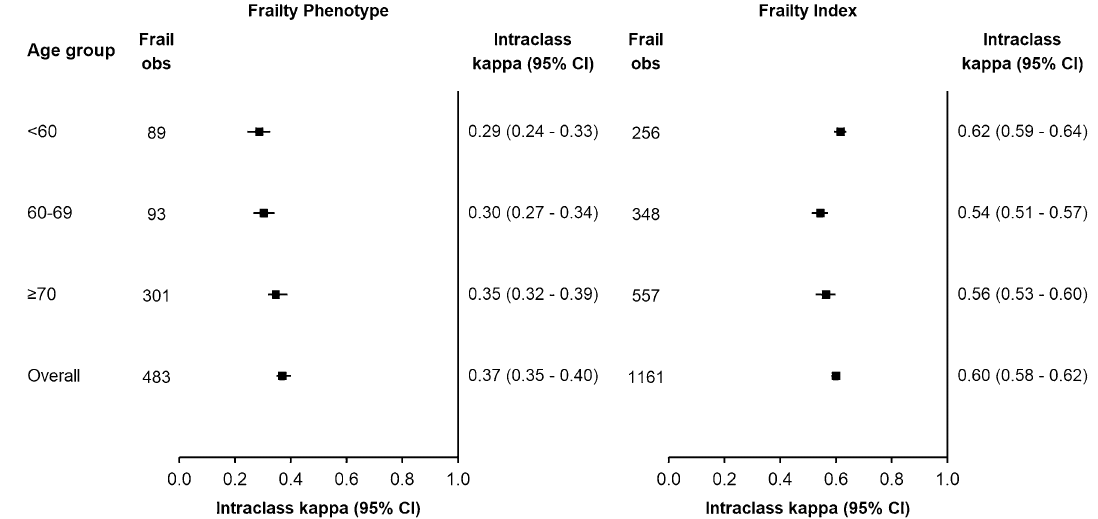
Figure 1. Agreement in classification of frailty over 2 years using frailty phenotype and frailty index, overall and by age group. Frail refers to the number of frail participants at Wave 1. Total participants at Wave 1 by age group were 3154 (< 60), 2265 (60–69); and 1866 (≥